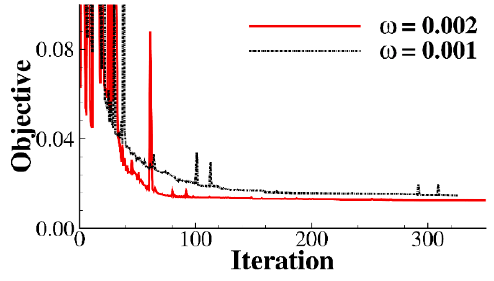
Figure 5. Convergence histories of the optimizations with different weights.